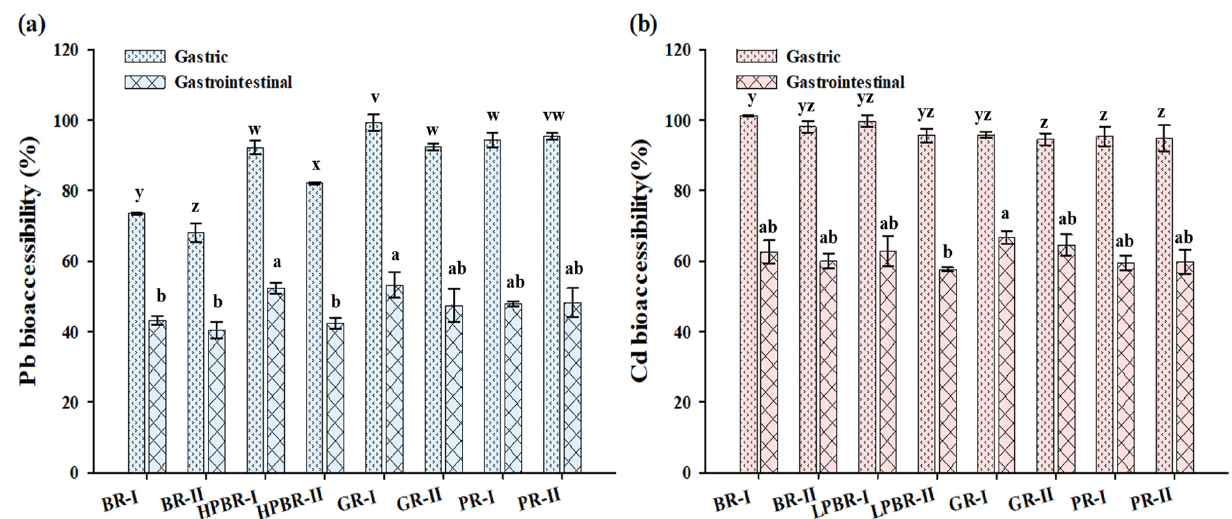
Figure 4. Effects of different polishing degrees on the bioaccessibility of Pb ( a ) and Cd ( b ) in rice. BR, brown rice; LPBR, lightly processed brown rice; GR, germinated rice; PR, polished rice. I and II indicate the two parallel processing in each polishing degree. xyz and abc indicate that the bioaccessibility of Cd in the gastric and intestinal phases in rice with different polishing degrees differs significantly at p < 0.05.